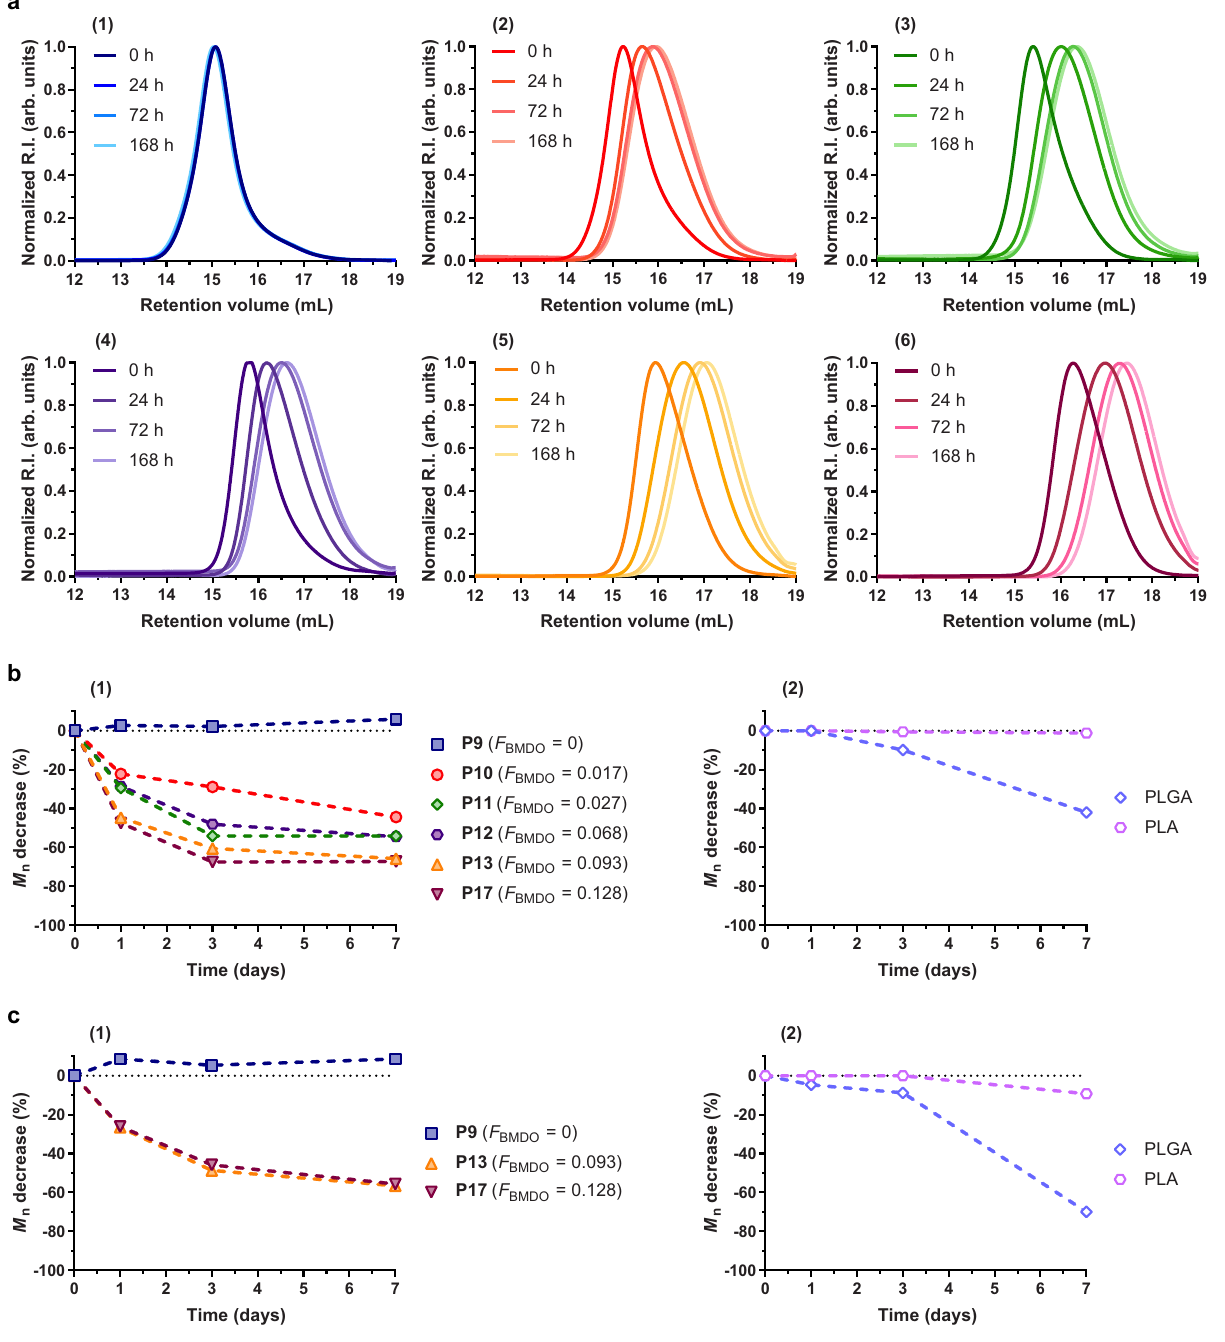
Fig. 6 Hydrolytic degradation in physiological conditions of P(AAm- co -BMDO) copolymers, PLA, and PLGA. a Evolution of the SEC chromatograms at different time during hydrolytic degradation in PBS (pH 7.4, 37 °C) of P(AAm- co -BMDO) copolymers (Table 2, P9 – P13 and P17 ) as a function F BMDO :